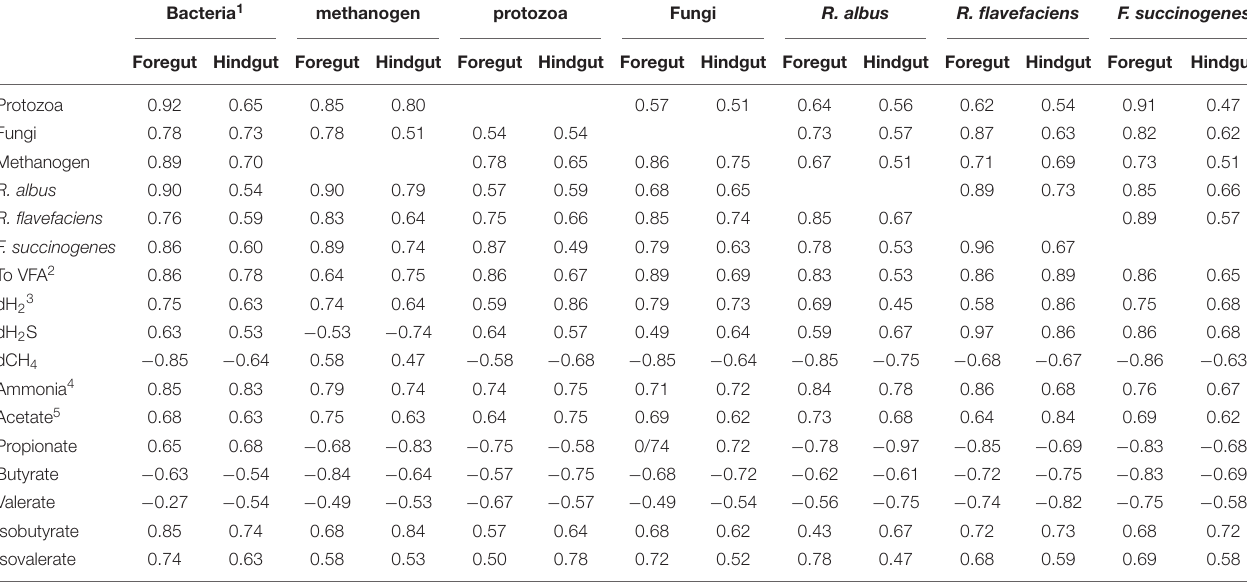
TABLE 7 | Correlation 1 between concentrations of microbial groups and fermentation metabolites in the gut regions of goats supplemented with amino acid. Bacteria